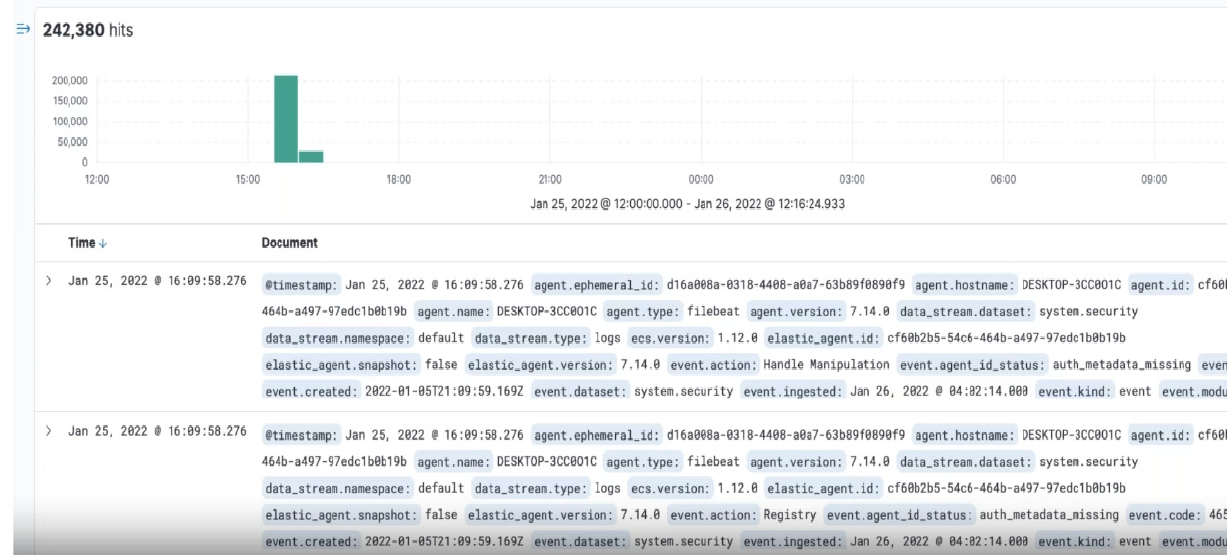
Figure 3. Elastic instance displaying threat logs.